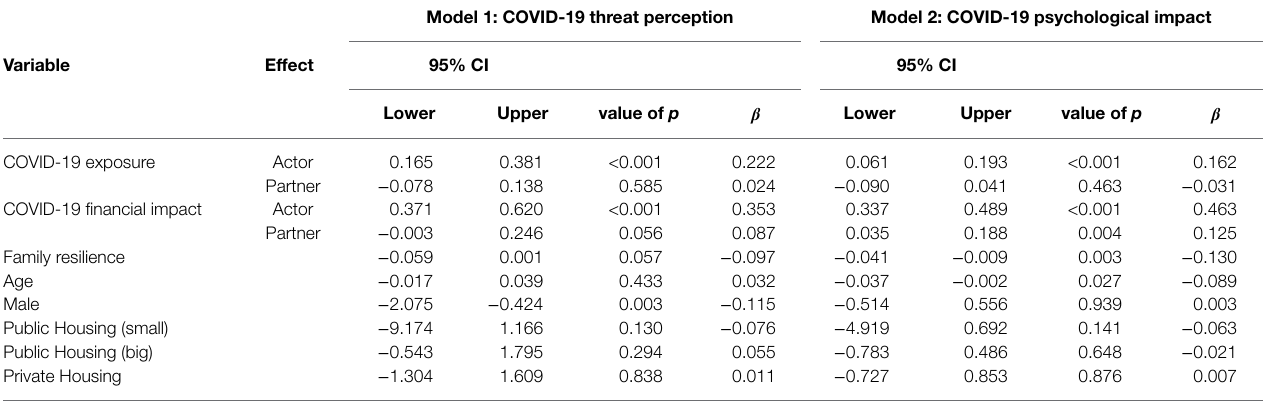
TABLE 4 | Summary of APIM analyses for Model 1 and Model 2.